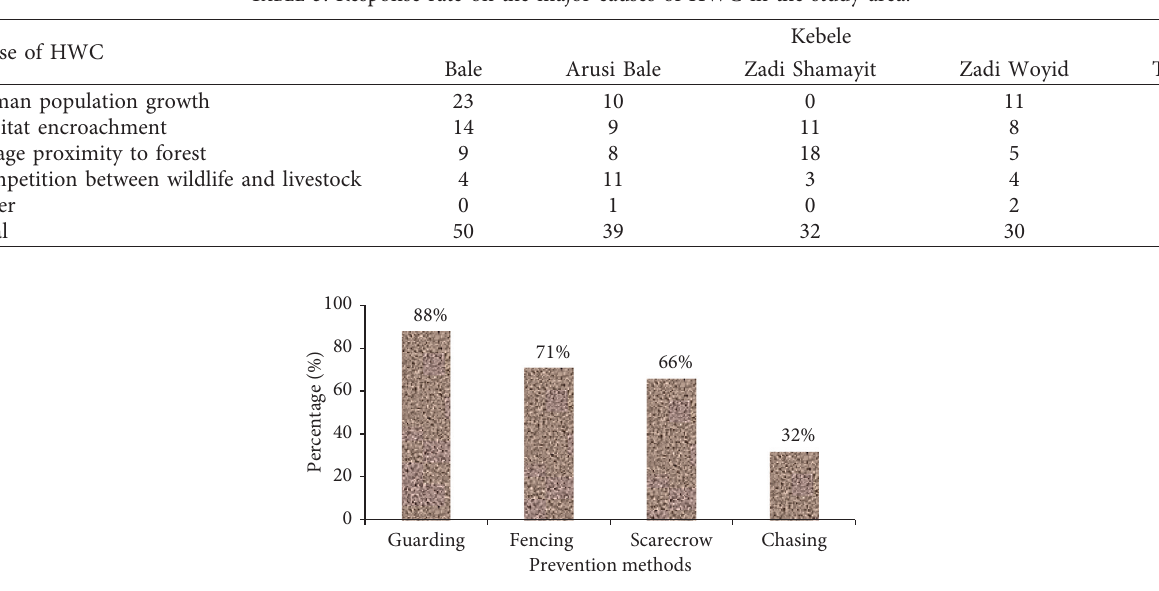
Figure 2: Measures to reduce HWC in the study area.